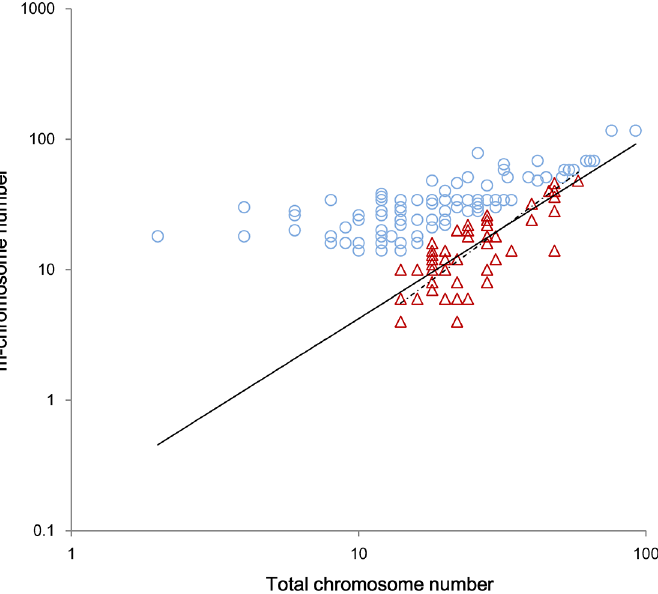
Fig 4. Cross-species scaling relationship of m-chromosome number vs. total chromosome number among deciduous species (D-group) and evergreen species (E-group). There are two regression lines of the reduced major axis (RMA) in the graph for the D-group (triangles and the solid line) and for the E-group (circles and the dashed line),